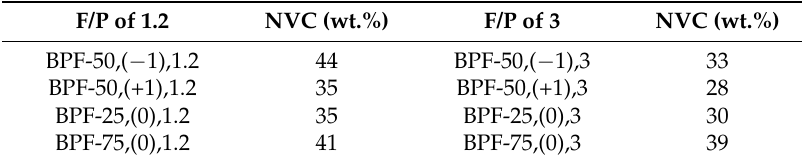
Table 5. NVC of BPF resoles with varying phenol percent substitutions (left to right). F/P of 1.2 NVC (wt.%) F/P of 3 NVC (wt.%)